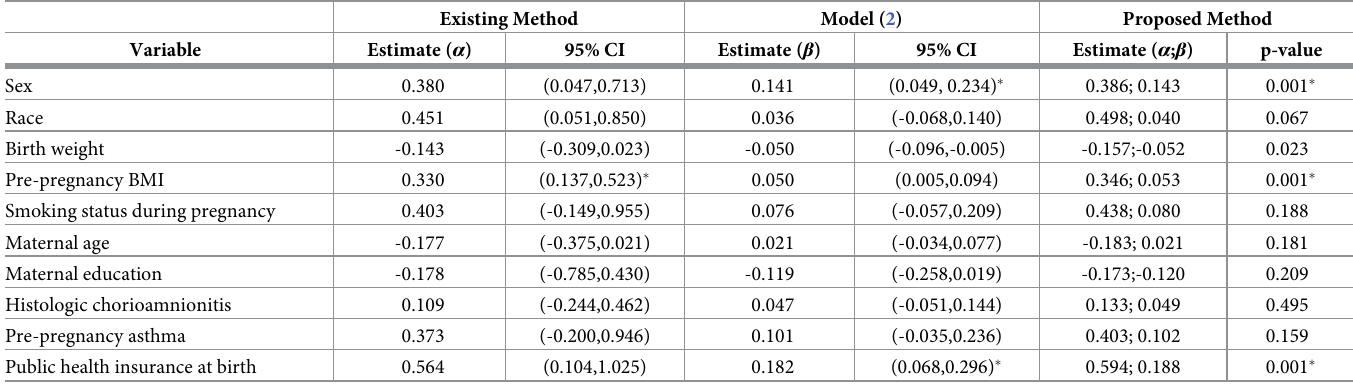
Table 2. PCHI data analysis